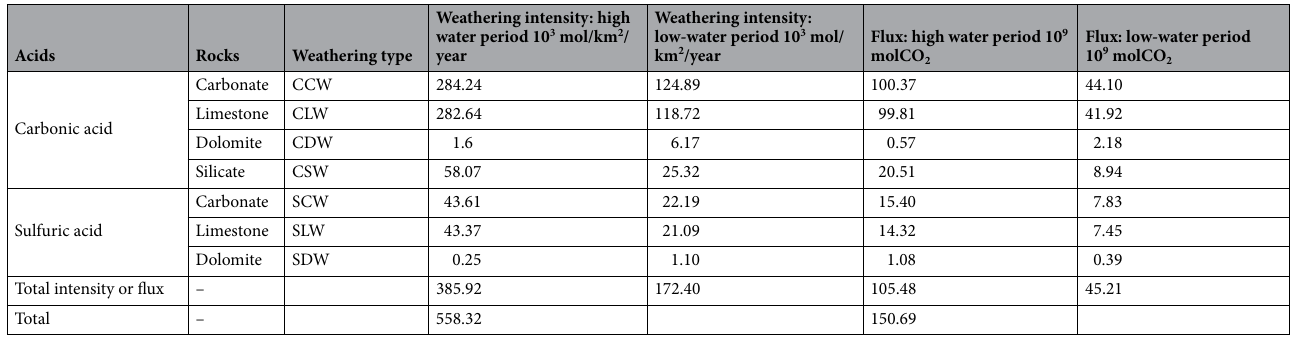
Table 10. CO 2 consumption for the Xijiang mainstream and main